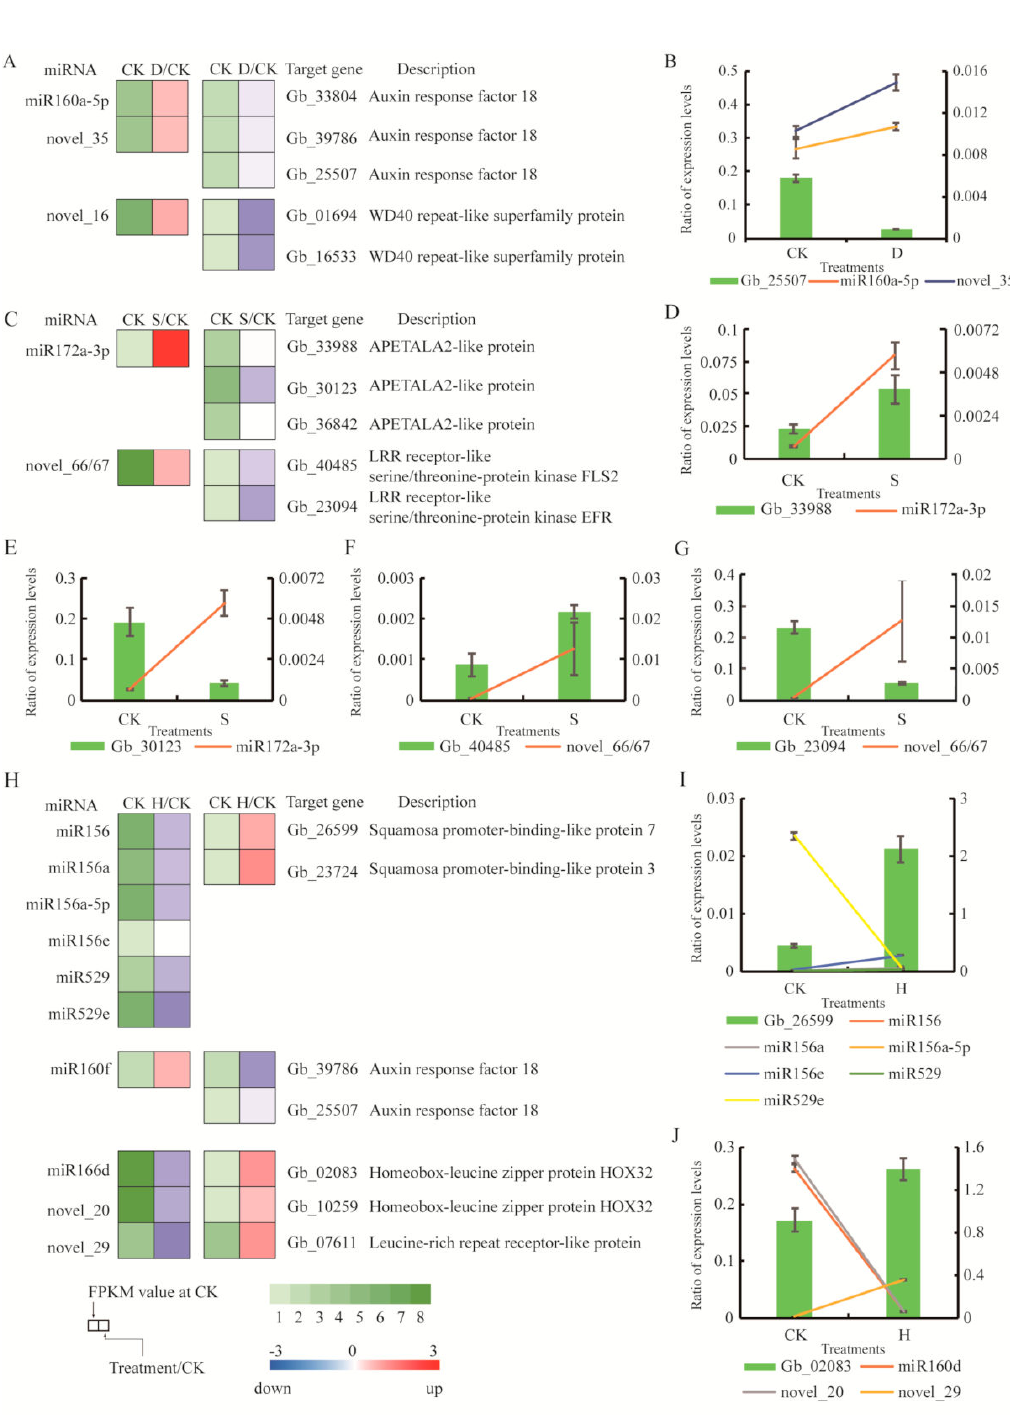
Figure 7. Expression of small RNAs and their corresponding targets in response to stress treatments. ( A ) Di ff erential expression of miRNAs and their target genes under drought. ( B ) qRT-PCR analysis of miR160a, novel_35, and their target genes under drought stress. ( C ) Di ff erential expression of miRNAs and their target genes under salt stress. ( D , E ) qRT-PCR analysis of miR172a-3p and their target genes under salt stress. ( F , G ) qRT-PCR analysis of novel_66 / 67 and their target genes under salt stress. ( H ) Di ff erential expression of miRNAs and their target genes under heat stress. ( I ) qRT-PCR analysis of miR156, miR156a, miR156a-5p, miR156e, miR529, miR529e, and their target genes under heat stress. ( J ) qRT-PCR analysis of miR160d, novel_20, novel_29, and their target genes under heat stress. CK: Control; D: Drought; S: Salt; H: